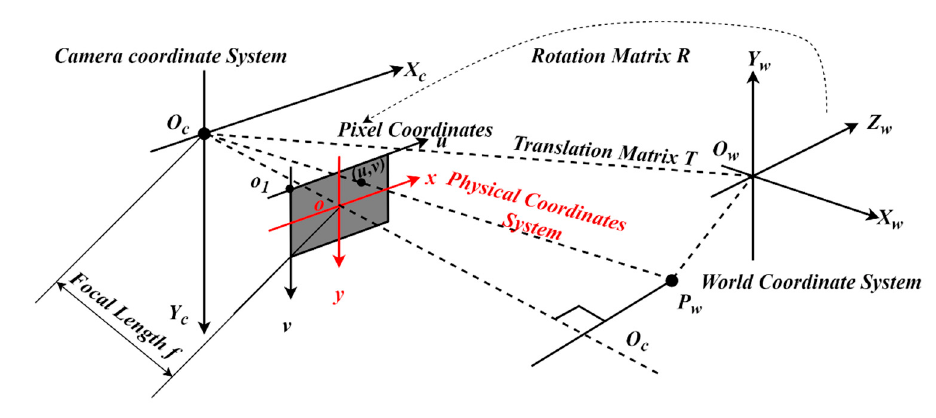
𝑃 (cid:3050) under the